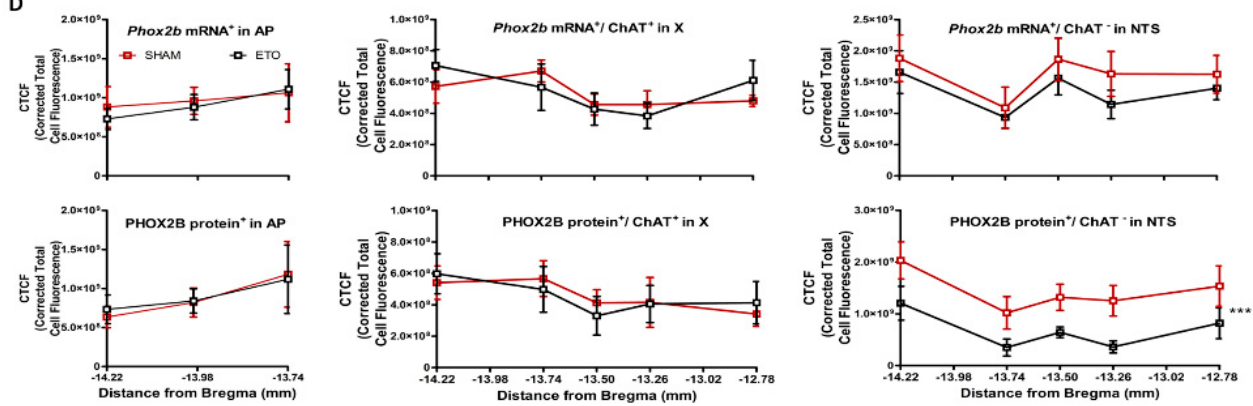
Figure 2. ETO reduces the expression of PHOX2B in NTS neurons. ( A ) Schematic and representative images of transverse brainstem sections at the level of the AP (top, − 13.47 mm distance from Bregma) and the DVC (bottom, − 13.50 mm distance from Bregma) showing the areas of interest illustrated in ( B , C ). ( B , C ) Phox2b + mRNA (red) and PHOX2B (blue) and ChAT protein (green) expression in AP ( B ), NTS neurons and X motoneurons. ( C ) in SHAM (top) and ETO (bottom) -treated rats (magnified view insert). Scale bar = 50 μ m. ( D ) Quantification of Phox2b mRNA (top) and protein (bottom) flu-